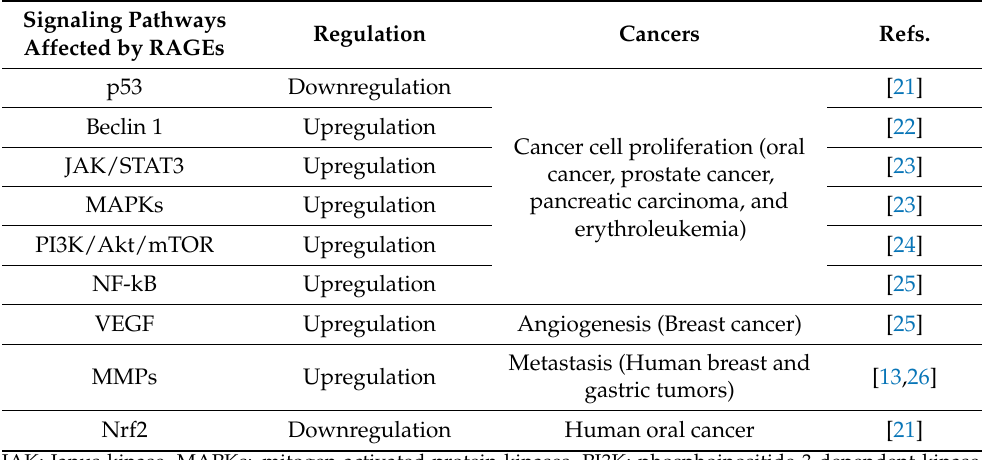
Table 1. Various signaling pathways affected by receptors for advanced glycation end products (RAGEs) in cancer